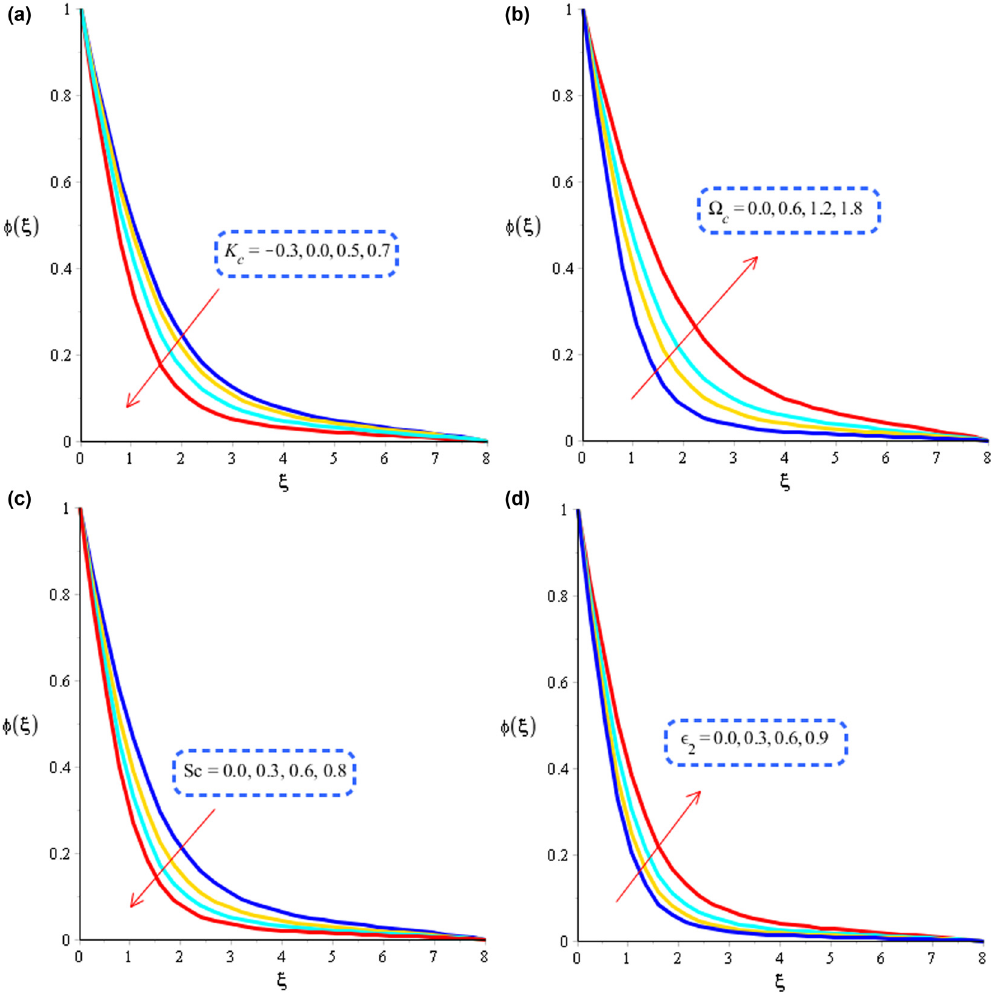
Figure 6: ( a ) Role of K c on concentration curves. ( b ) Role of Sc on concentration curves. ( c ) Role of Ω c on concentration curves. ( d ) Role of ε 2 on concentration